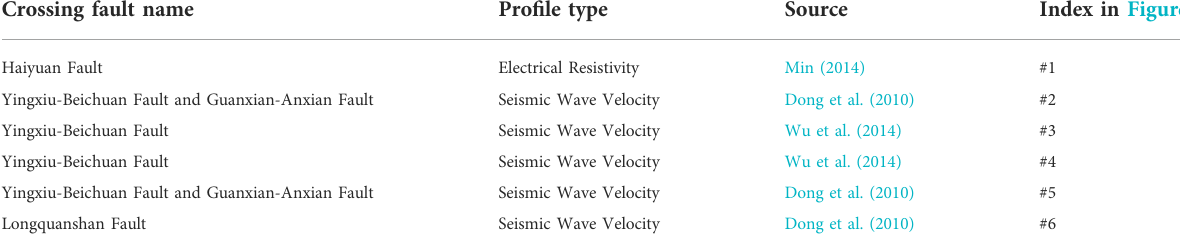
TABLE 1 Information on the six collected geophysical pro fi les in the